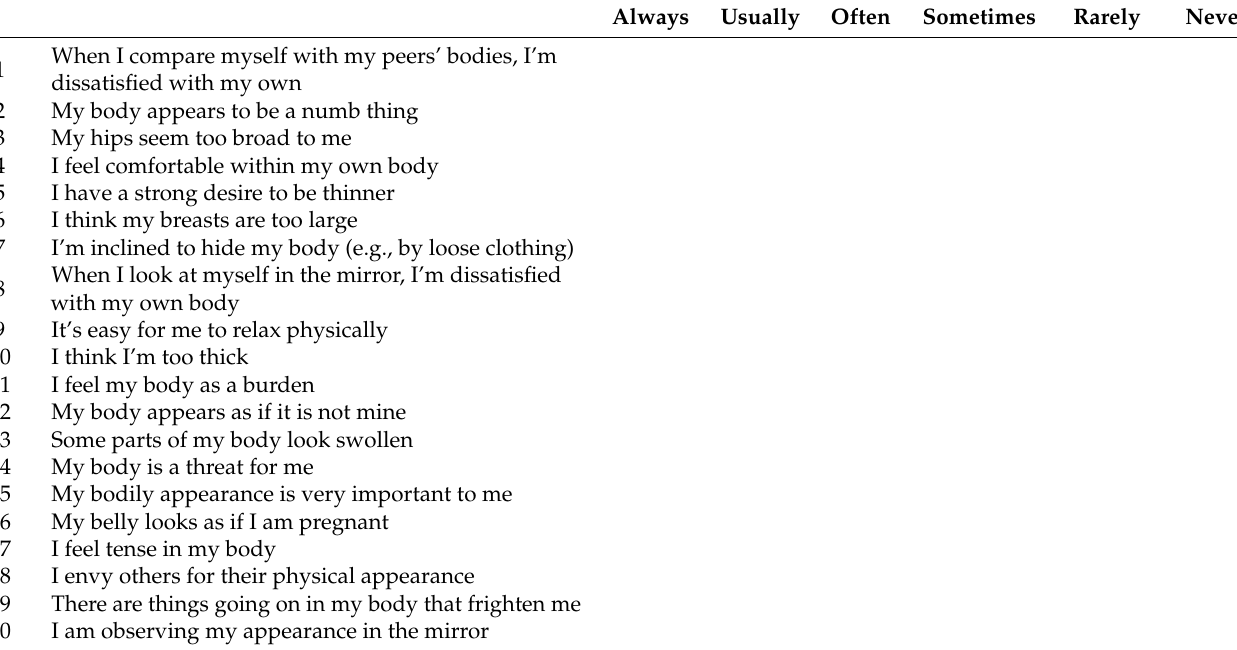
Table A1. BODY—ATTITUDE—TEST